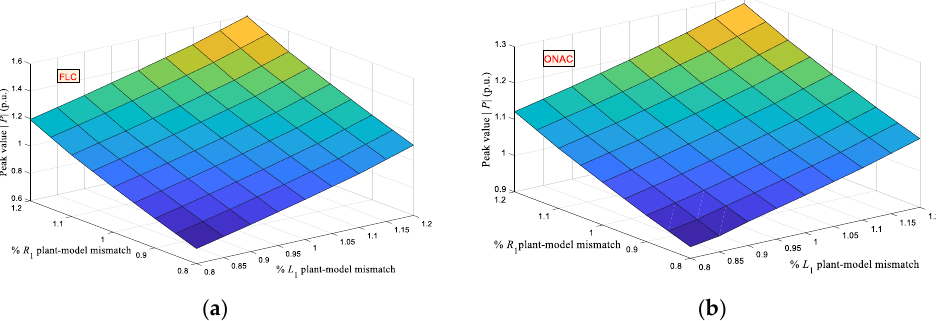
Figure 12. Peak value of active power | P | obtained under a 50% voltage drop lasting 100 ms at VSC with 20% variation of the equivalent resistance R 1 and inductance L 1 of FLC and ONAC. ( a ) FLC and ( b ) ONAC.